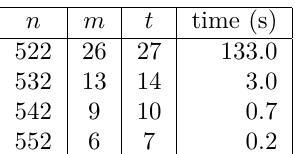
Table 4: Lattice attack